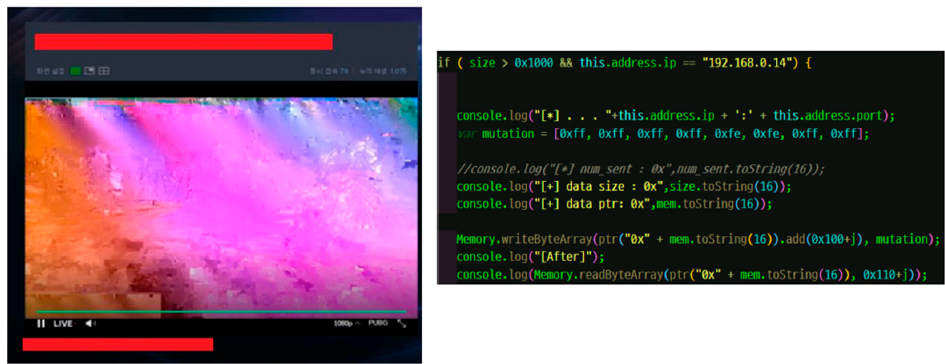
Figure A7. Example of DoS attack through video data tempering (picture distortion)